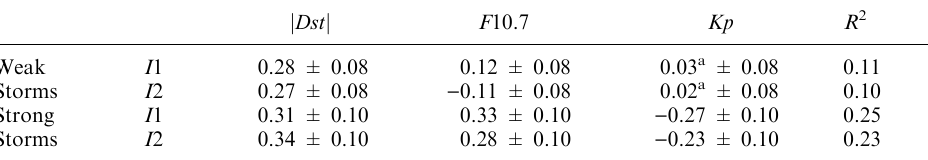
Table 5. Dependence of partial correlation coe(cid:129)cients on the storm intensity